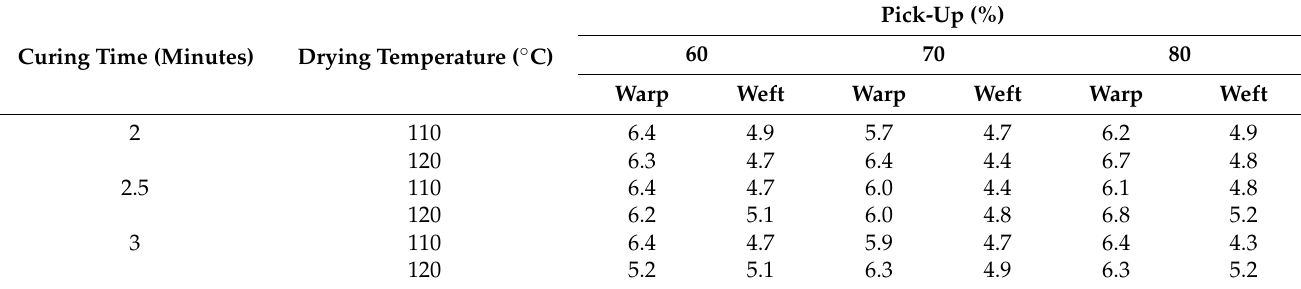
Table 5. Relationship between warp and weft in tearing strength.